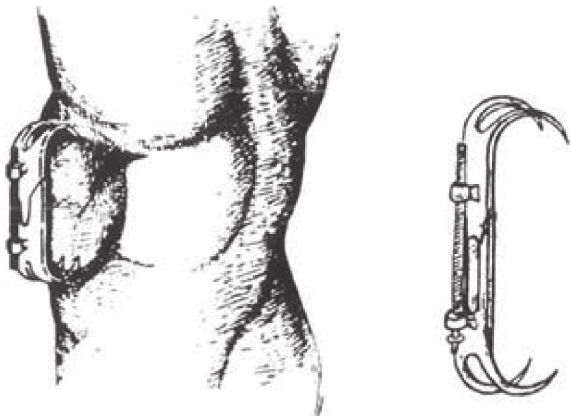
Figure 5: Malgaigne double-sided paired metal transcutaneous patella hook clamp (figure reproduced with permission